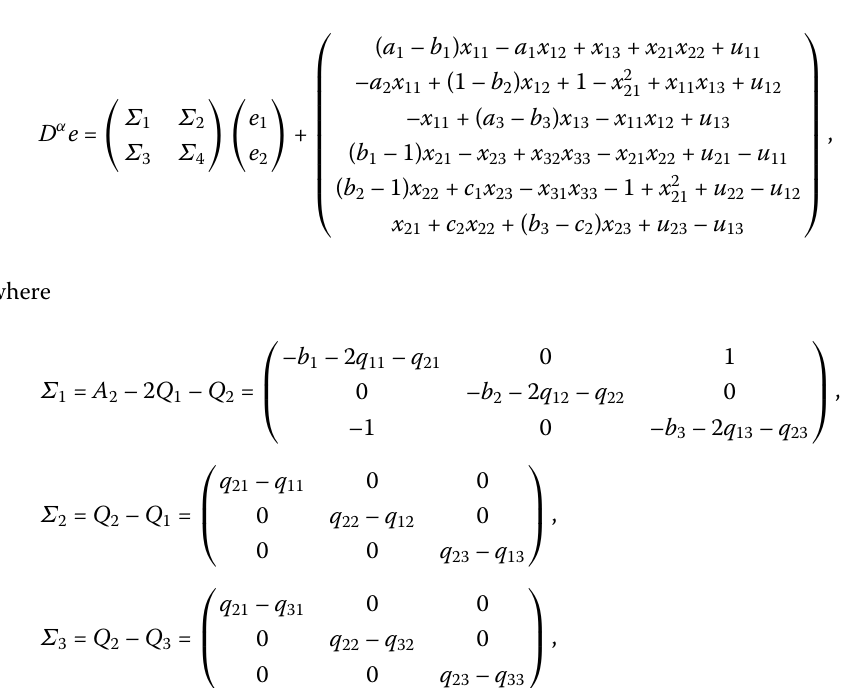
( a 1 , a 2 , a 3 ) = (10,28,8/3), ( b 1 , b 2 , b 3 ) = (3,0.1,1), and ( c 1 , c 2 ) = (50,4). In the absence of the controllers, fractional-order systems (9)–(11) without the coupling terms behave chaoti- cally as shown in Fig. 5; see [6, 8, 9] for more